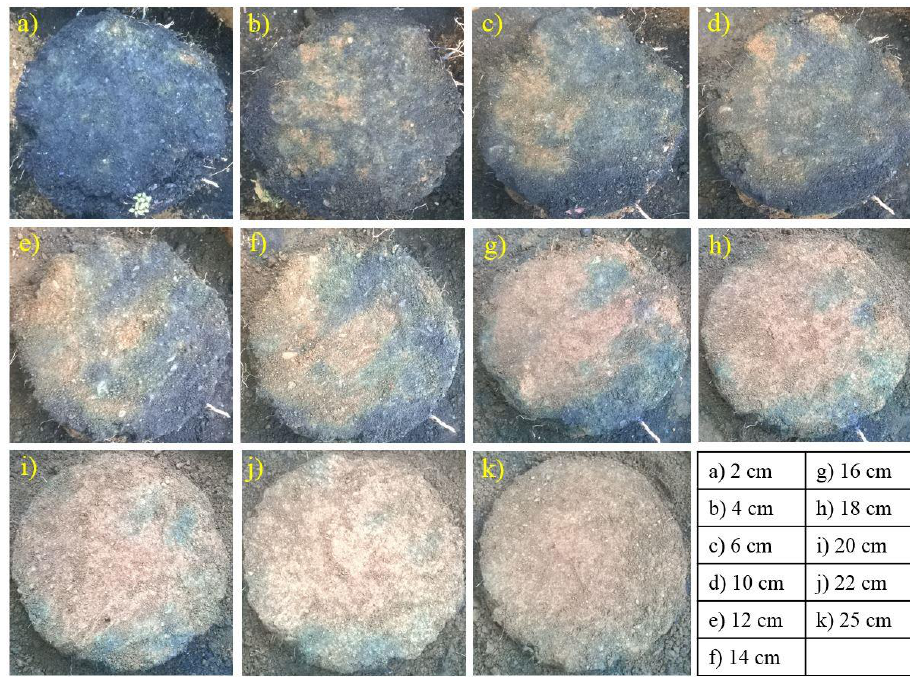
Figure 5. ( a – k ) Subset digitally pre-processed images of soil samples used in macropore analysis of the hillslope at different depths mentioned in the